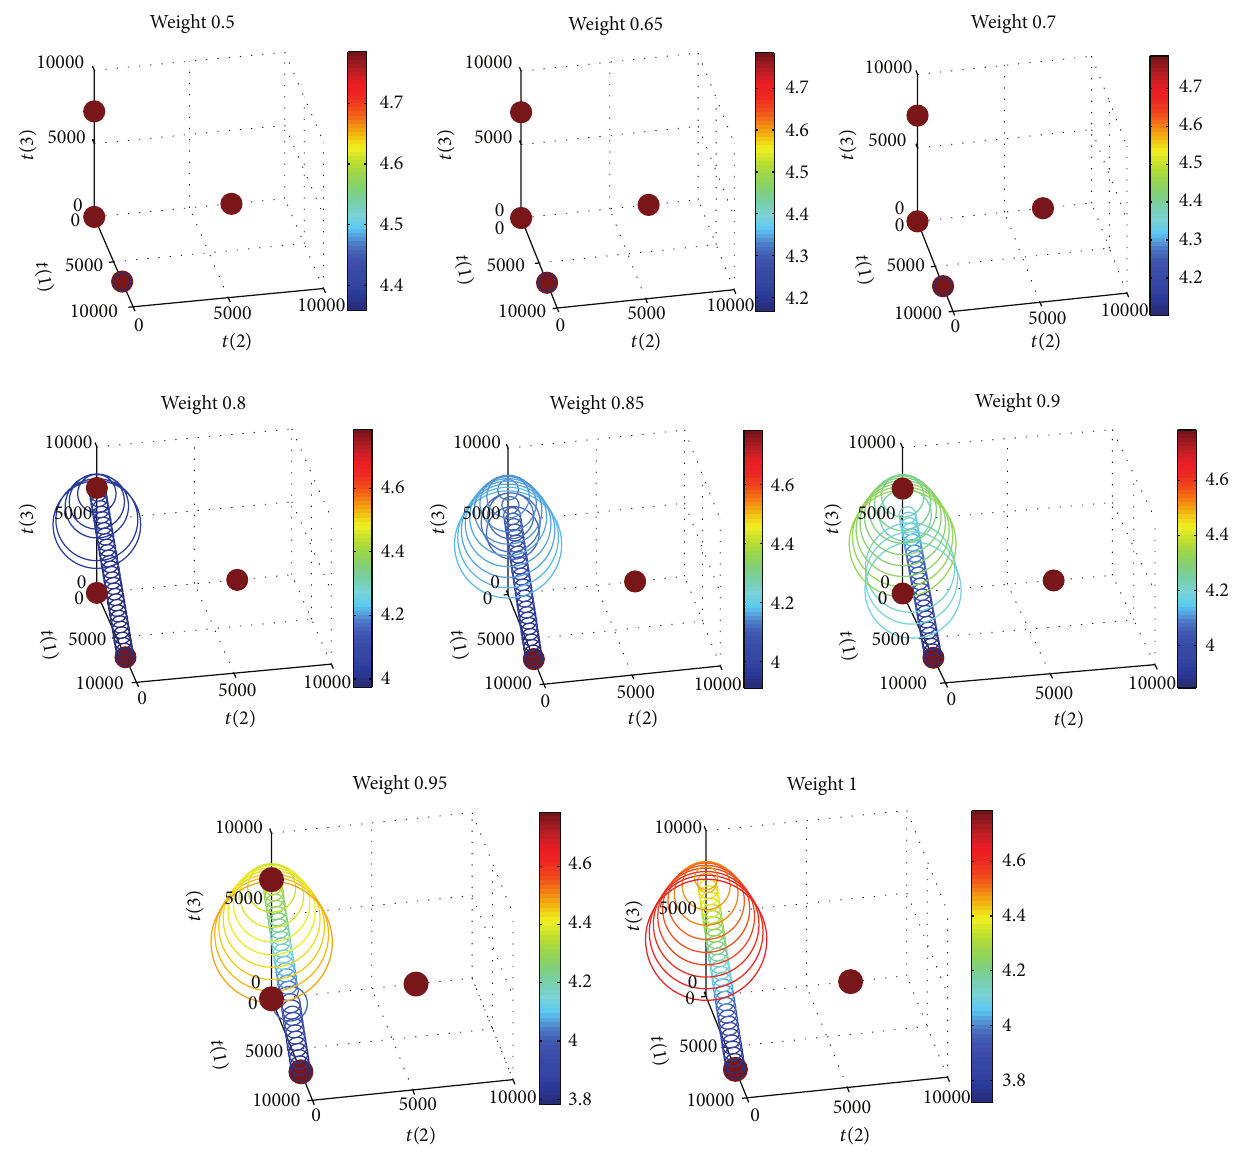
Figure 11: Evolution of optimization strategies with 0.5 ≤ 𝑤 ≤ 1 in the input